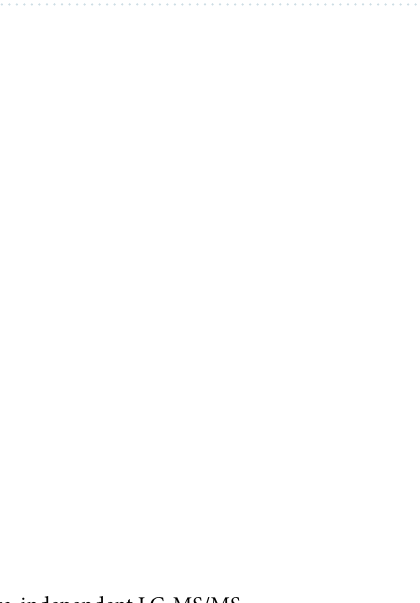
Figure 1. Low collision energy spectra from the GP-SWATH DIA of the following glycoforms of the SWPAVGNCSSALR glycopeptides of hemopexin: ( A ) bi-antennary core fucosylated glycoform, precursor m/z = 1058.4, major quantification fragment m/z mono = 1404,6; and ( B ) bi-antennary glycoform without fucose, precursor m/z = 1009.8, major quantification fragment m/z mono = 1331.6 .